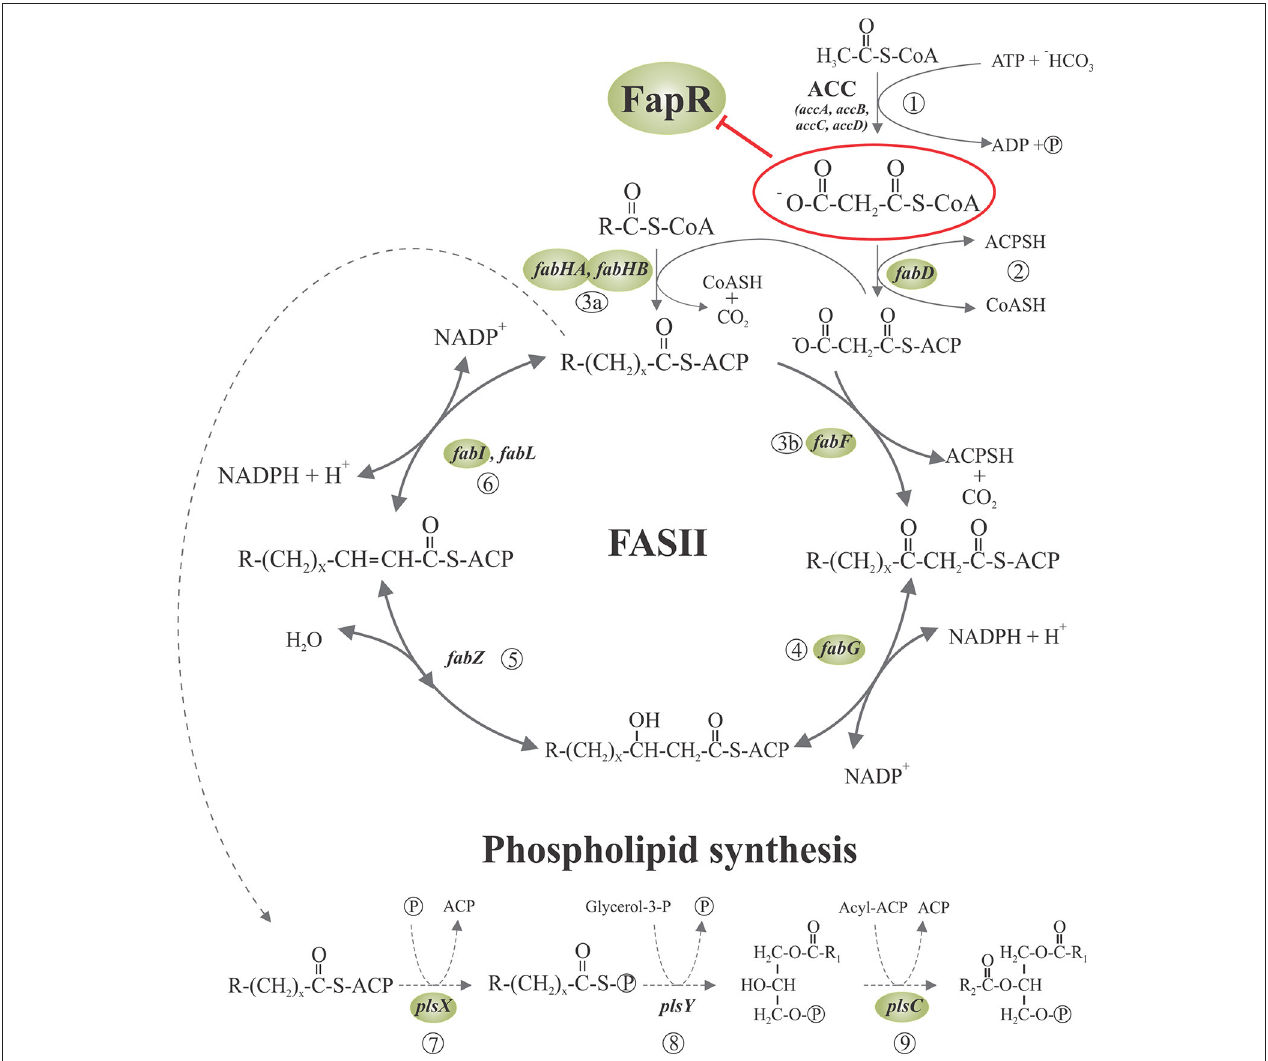
FIGURE 1 | Fatty acid synthesis and phospholipid initiation steps in Bacillus subtilis . Malonyl-CoA is generated from acetyl-CoA by acetyl-CoA carboxylase (ACC) (1) and then is transferred to ACP by malonyl-CoA transacylase (2). The FabH condensing enzymes initiates the cycles of fatty acid elongation by condensation of acyl-CoA primers with malonyl-ACP (3a). The resultant β -ketoester is reduced by the β -ketoacyl-ACP reductase (4). Then, the β -hydroxyacyl-ACP is dehydrated to the trans-2 unsaturated acyl-ACP by β -hydroxyacyl-ACP dehydrase (5), which is finally reduced by enoyl reductase (6). Subsequent rounds of elongation are initiated by the elongation-condensing enzyme FabF (3b) to generate an acyl-ACP two carbons longer than the original acyl-ACP at the end of each cycle. The long chain acyl-ACP end products of fatty acid synthesis are transacylated in three steps to glycerolphosphate, to generate phosphatidic acid (PA), a key intermediate in the synthesis of phospholipids. First, PlsX catalyzes the synthesis of fatty acyl-phosphate from acyl-ACP (7); then, PlsY transfers the fatty acid from the activated acyl intermediate to the 1-position of glycerol-3-phosphate (8) and finally, lyso-PA is acylated to PA by PlsC (9). Expression of the genes surrounded by shaded ellipses is repressed by the transcriptional regulator FapR, whose activity is, in turn, antagonized by malonyl-CoA (enclosed in a red ellipse). R denotes the terminal group of branched-chain or straight-chain fatty acids. Adapted from Albanesi et al.